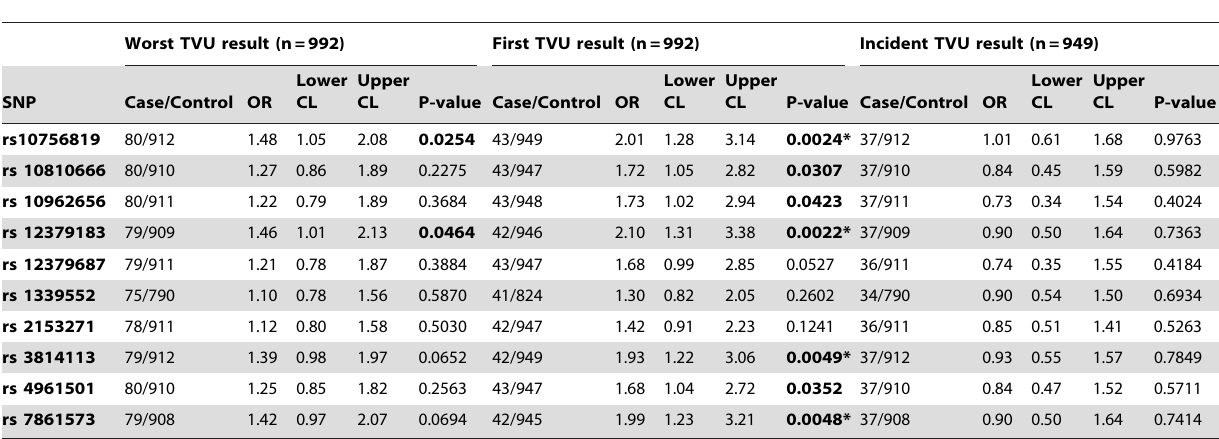
Table 2. Association of 10 SNPs on 9p22 with abnormal TVU screening